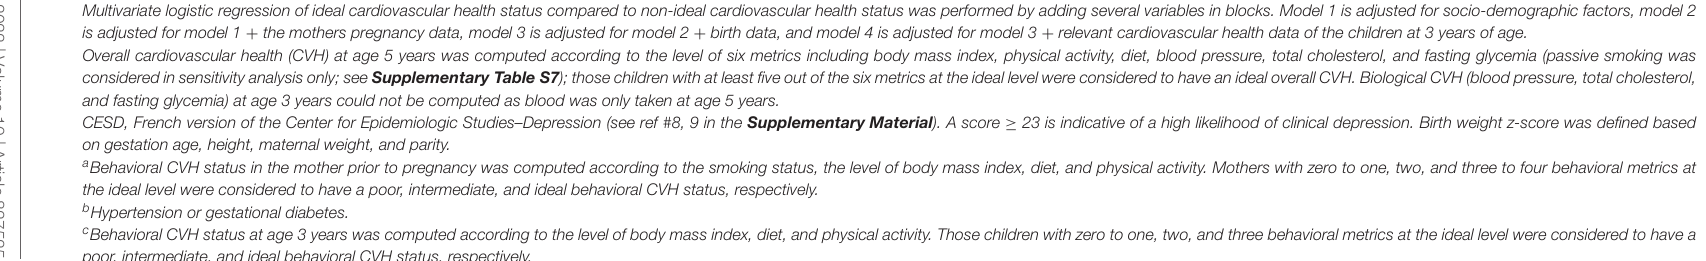
Overall cardiovascular health (CVH) at age 5 years was computed according to the level of six metrics including body mass index, physical activity, diet, blood pressure, total cholesterol, and fasting glycemia (passive smoking was consideredinsensitivityanalysisonly;see Supplementary Table S7 );thosechildrenwithatleastfiveoutofthesixmetricsattheideallevelwereconsideredtohaveanidealoverallCVH.BiologicalCVH(bloodpressure,totalcholesterol, and fasting glycemia) at age 3 years could not be computed as blood was only taken at age 5 years. CESD, French version of the Center for Epidemiologic Studies–Depression (see ref #8, 9 in the Supplementary Material ). A score ≥ 23 is indicative of a high likelihood of clinical depression. Birth weight z-score was defined based on gestation age, height, maternal weight, and parity. a Behavioral CVH status in the mother prior to pregnancy was computed according to the smoking status, the level of body mass index, diet, and physical activity. Mothers with zero to one, two, and three to four behavioral metrics at the ideal level were considered to have a poor, intermediate, and ideal behavioral CVH status, respectively. b Hypertension or gestational diabetes. c Behavioral CVH status at age 3 years was computed according to the level of body mass index, diet, and physical activity. Those children with zero to one, two, and three behavioral metrics at the ideal level were considered to have a poor, intermediate, and ideal behavioral CVH status,